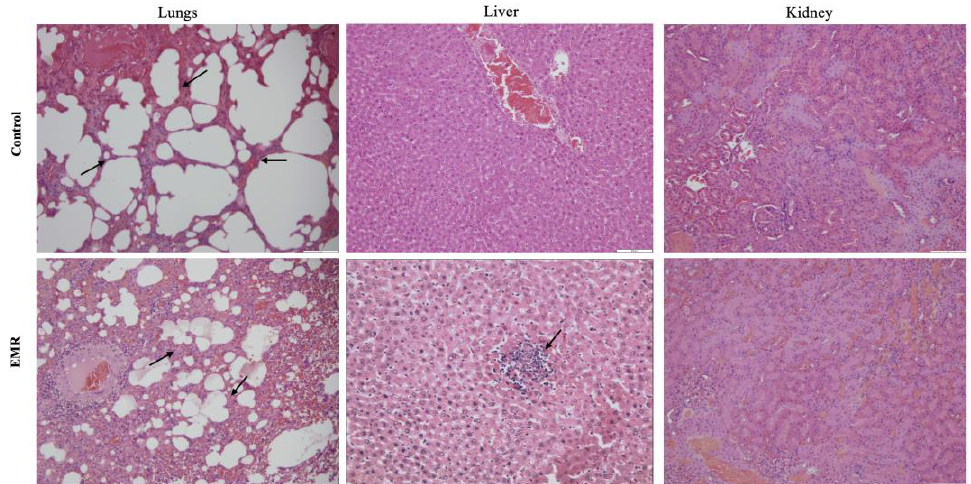
Figure 4. The effect of 150 kHz IF EMR on the histopathology of lung, liver, and kidney of rats in the control and EMR groups after 2 months of whole-body exposure (H&E × 200). The lungs displayed congestion and thickened alveolar walls (arrows) in both groups, but the intensity was more in EMR group. The liver showed typical hepatic cords with sinusoids and the central vein in both groups but mild parenchymal lymphatic infiltration (arrow) was found in the EMR group (H&E × 400). The kidney showed normal renal corpuscles, tubules, and collecting ducts in both groups.